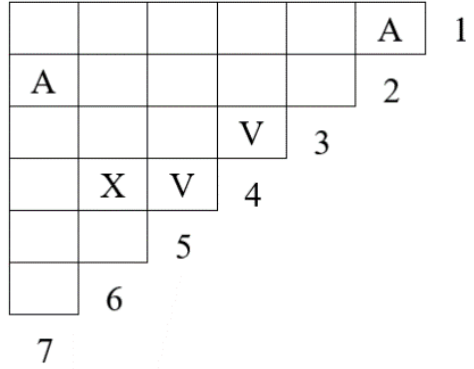
Figure 3. Box plot of the interactions between the factors.